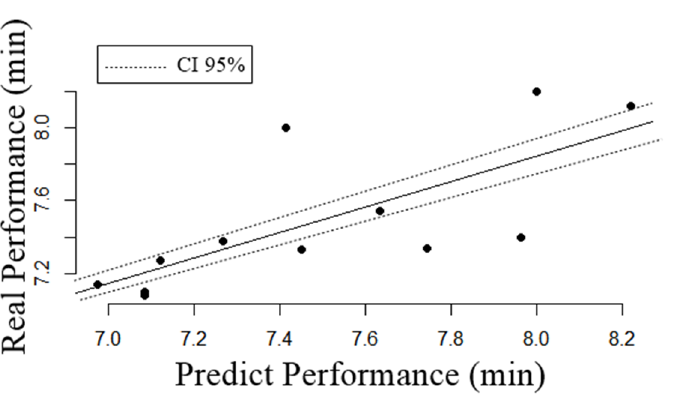
Figure 3. Comparison of the result predicted by the mathematical model with the result of the 2000 m test in indoor rowing. CI 95%: Confidence Interval of 95%. (min): Minutes.